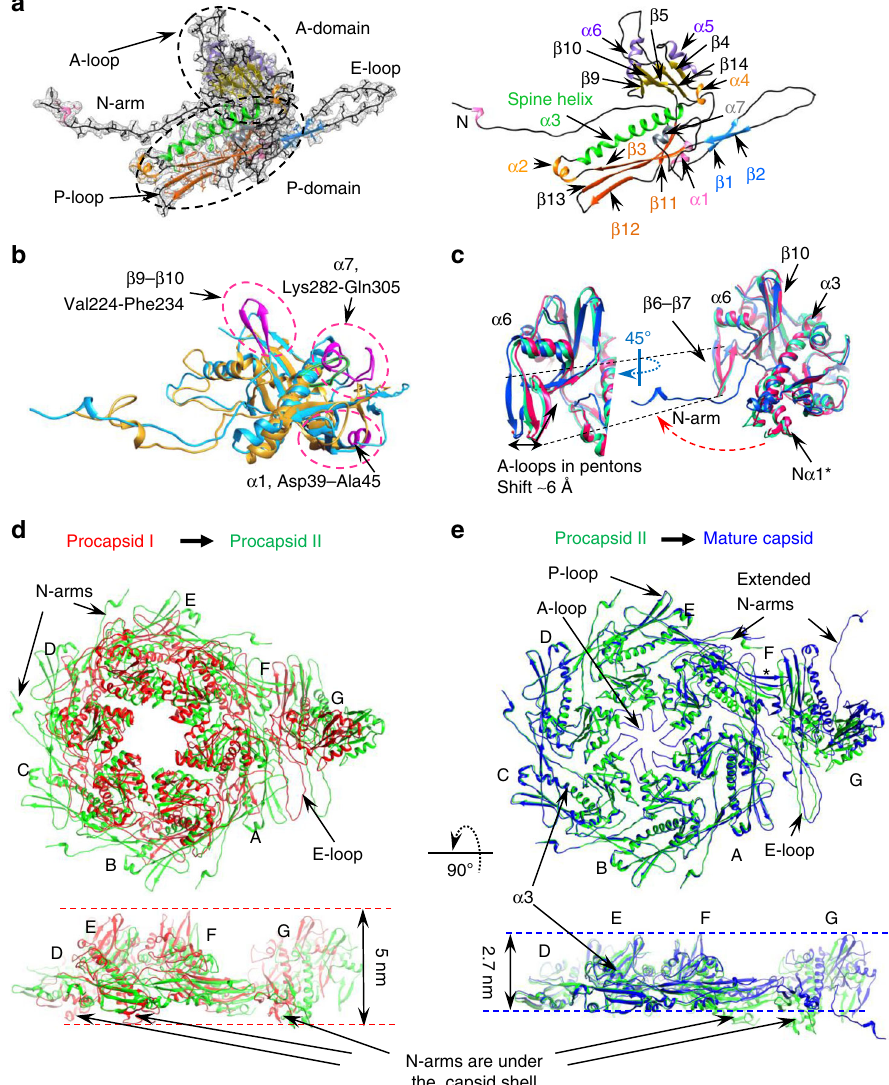
Fig. 2 Conformational plasticity of the capsid protein gp13 throughout assembly. a The gp13 atomic model is traced de novo within the cryo-EM density of a MCV subunit (left). Secondary structure elements are shown on the right panel. b Superposition of atomic models of SPP1 gp13 (in cyan) and phage HK97 gp5 (PDB 1OHG, in gold). The additional structural elements of gp13 are shown in magenta. c Superposition of the G subunits that form pentons in three capsid states: procapsid I in red, procapsid II in green, and MVC in blue. The β -hairpin β 9- β 10 adopts the most vertical position in procapsid I. d Overlay of the ASUs from procapsid I and procapsid II viewed from the outside (top) and from the side (bottom). e Overlay of the ASUs from procapsid II and